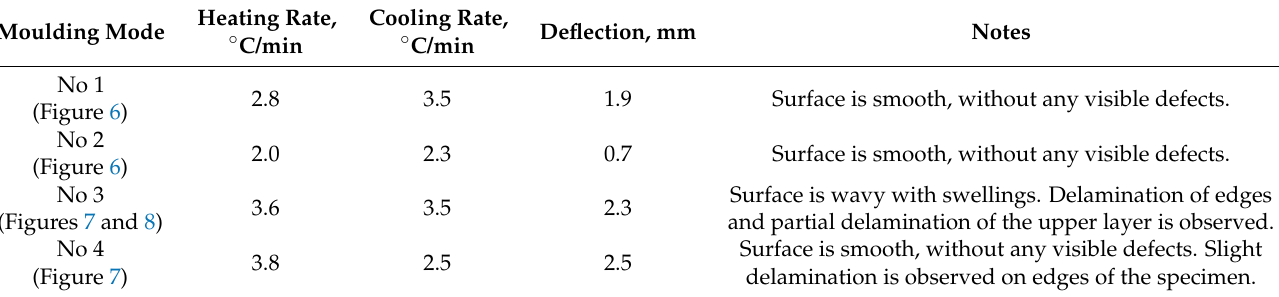
Table 4. Processing of results of the experiment.